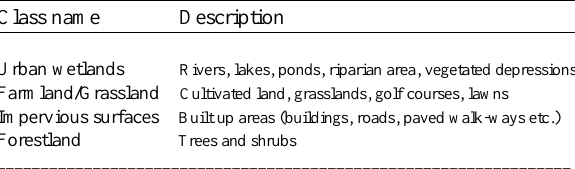
Table 1: The land-cover classification scheme For the traditional approach, a supervised classification with the maximum likelihood classifier was applied to the SPOT images of 1992, 2008, and 2010. For the knowledge-based classification, we developed a knowledge base for urban wetland classification, which consists of a set of decision rules that describe the conditions defining occurrences of various wetland types. The decision rules were applied to the base maps generated through the traditional classification using the ERDAS IMAGINE Expert Classifier software.